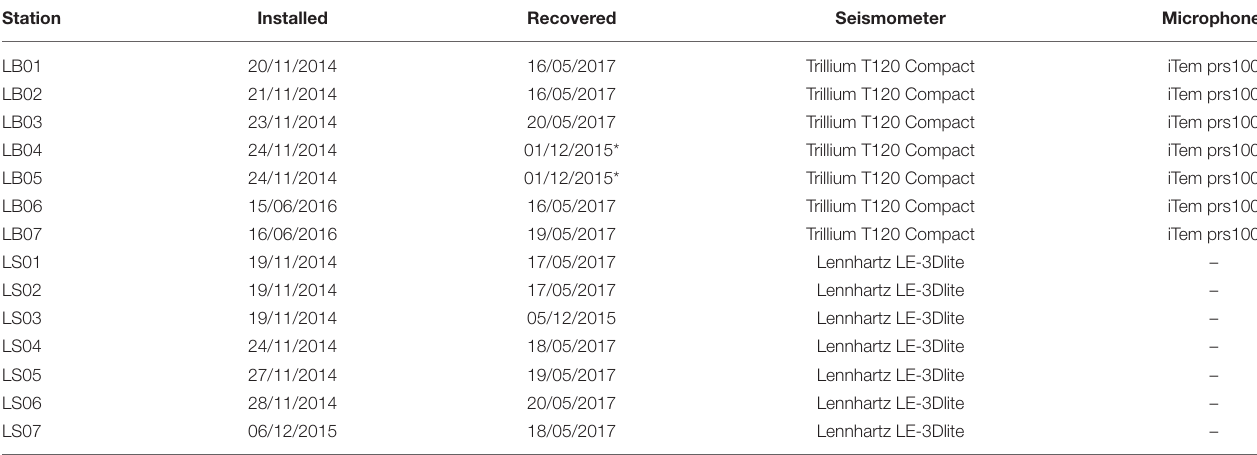
TABLE 1 | Details of the stations deployed in the temporary network at Santiaguito dome complex. Station Installed Recovered Seismometer Microphone